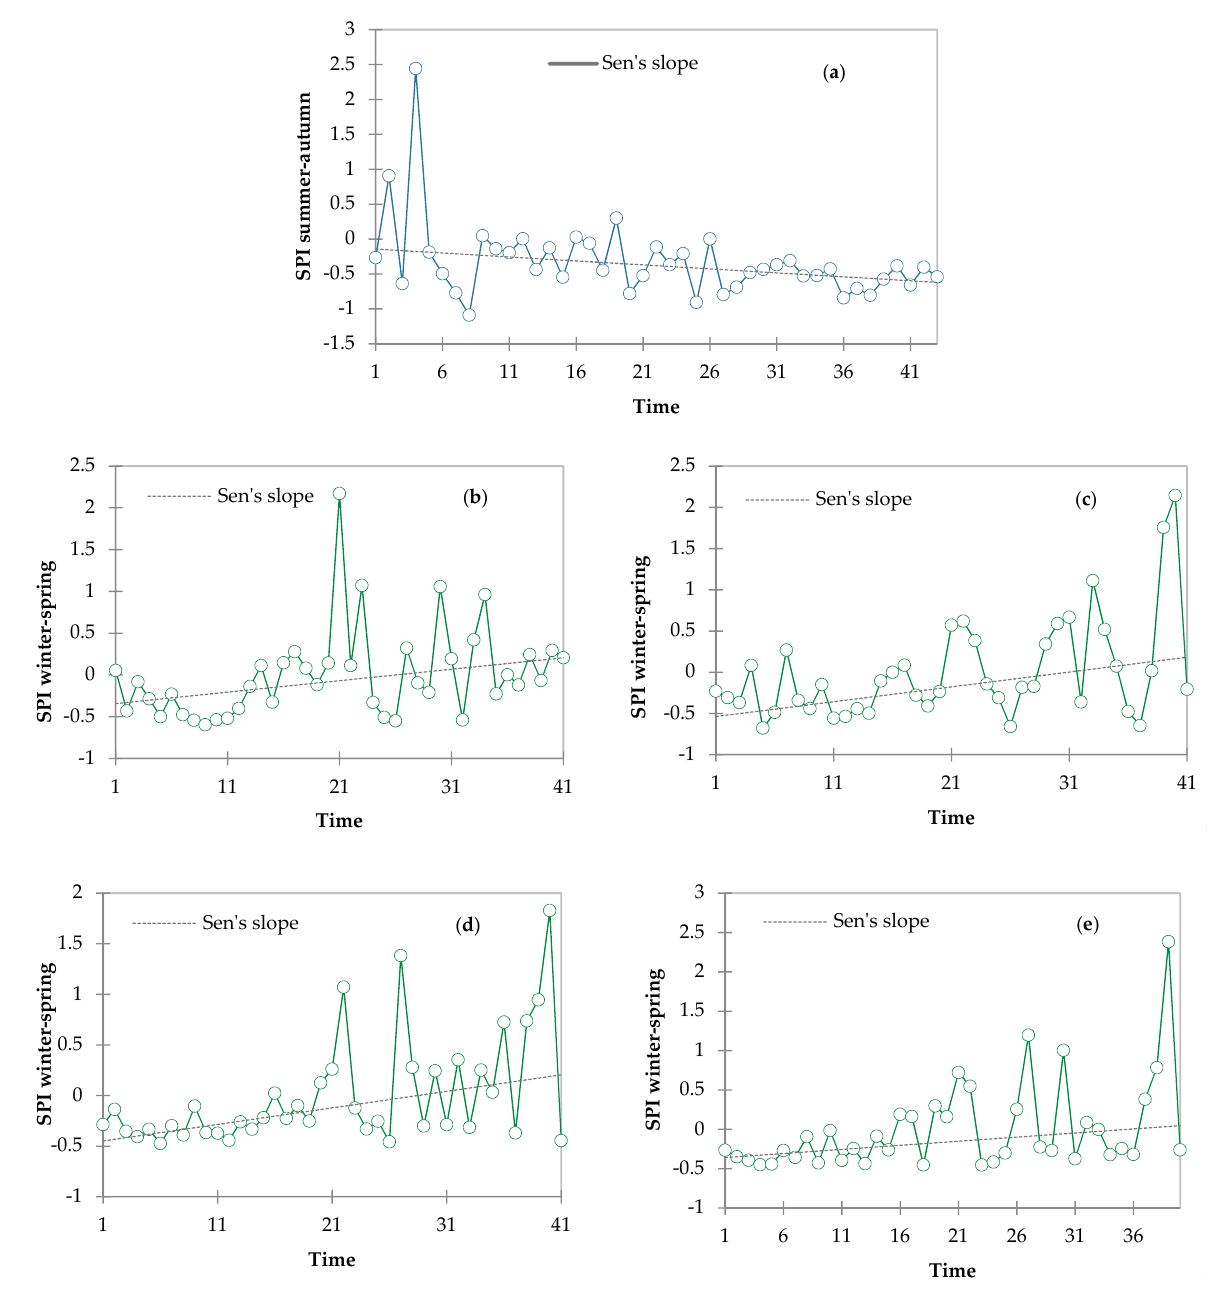
Figure 6. Trend analysis of seasonal drought events at selected meteorological stations over a 40-year period using the Mann–Kendall test and Sen’s slope: ( a ) Tri Ton Station, ( b ) Ca Mau Station, ( c ) Kien Giang Station, ( d ) My Tho Station, and ( e ) Ba Tri Station.The results of the probability analysis and return periods are shown in Figure A1 (Ca Mau and Bac Lieu stations only) and Table 2. The return period is defined by (T = 1/P) or (T = 1/(1 − P) depending on P values, in which, P denotes the probability of occurrence or exceedance of an event and T denotes the return period. The value of the return period was used, based on how frequently droughts or wet periods occur. Table 2 shows a comprehensive summary for the occurrence of drought conditions for different cropping seasons and for different return periods. It was found that the VMD experiences very light droughts (SPI ≤ − 0.25) or very slight wet periods (SPI ≥ 0.25) more frequently during the winter and spring months. Overall, on average, 97% of the entire study area will experience a very slight drought in a 3-year return period, and 96% of the area will experience a very slight wet period (SPI ≥ 0.25) for the winter-spring rice cropping over a 4-year return